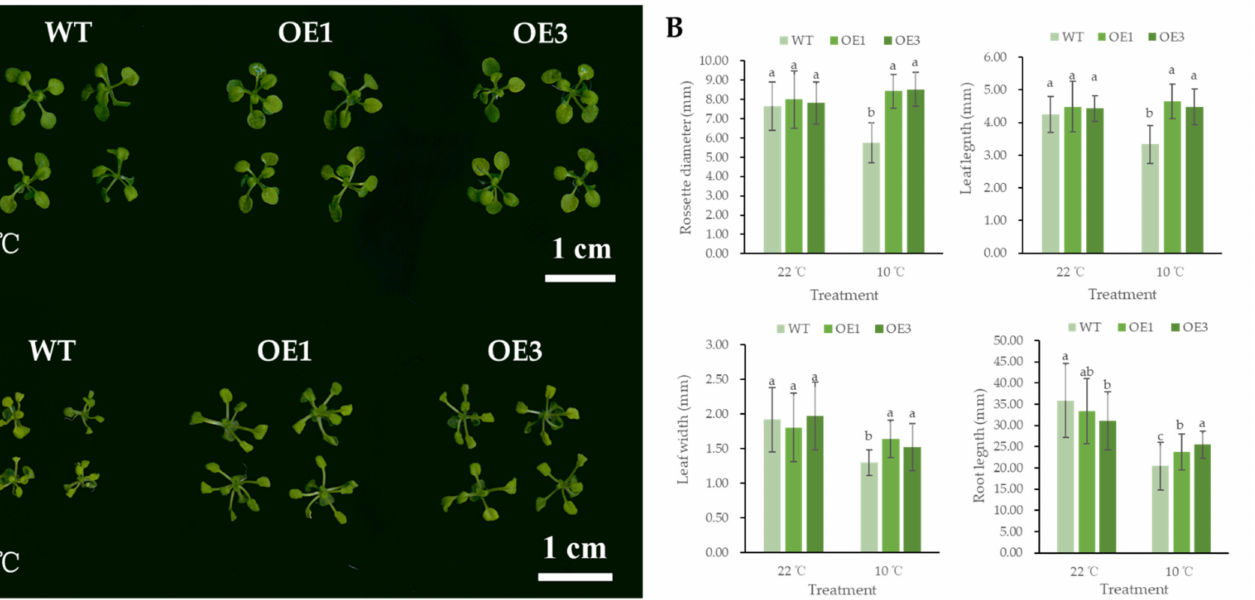
Figure 4. Phenotypic differences between wild-type (WT) and SgGH3.1 overexpressing (OE1 and 3) A. thaliana seedlings cultured at 22 ◦ C and 10 ◦ C. ( A ) Scans of Arabidopsis seedlings. ( B ) Phenotypic measurements of Arabidopsis seedlings. Different letters above the columns indicate significant differences at p < 0.05 between different Arabidopsis lines within the same